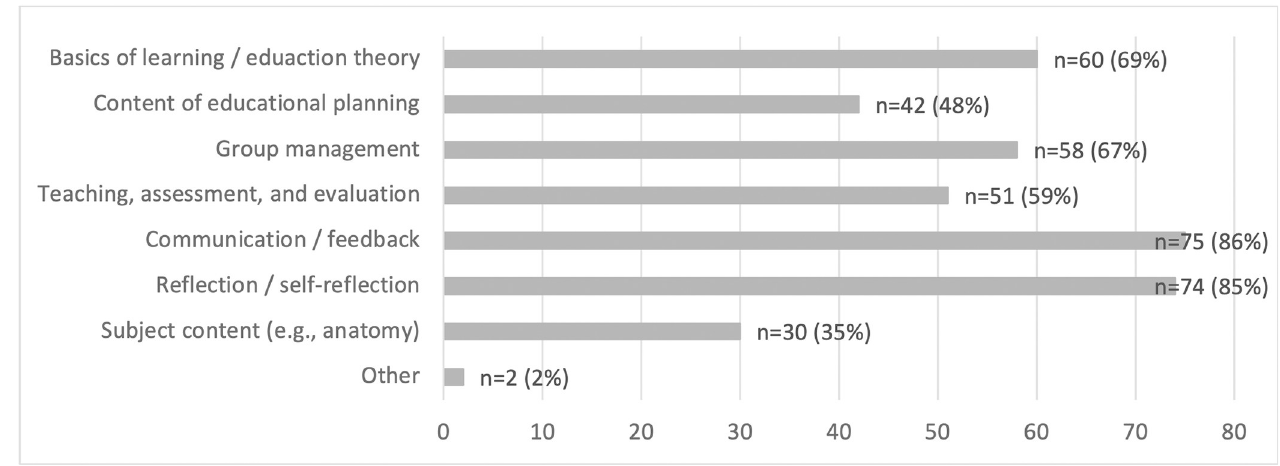
Fig 6. Content of preparatory measures [multiple answer options, sample n =